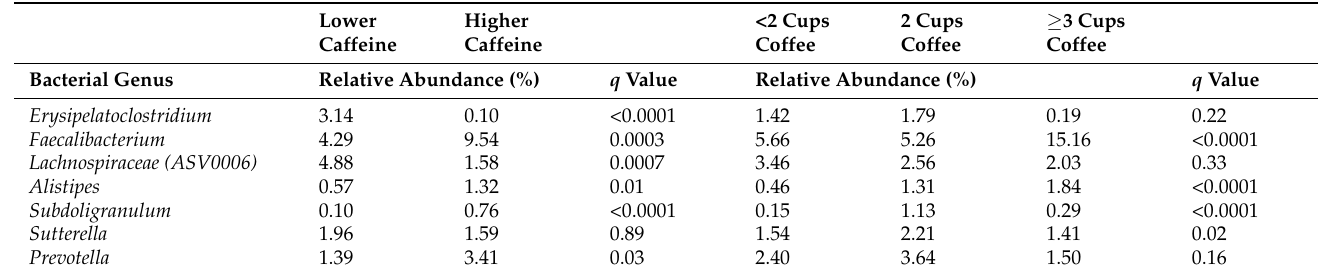
Table 2. Relative abundance of bacterial genera by intake of caffeine and coffee.